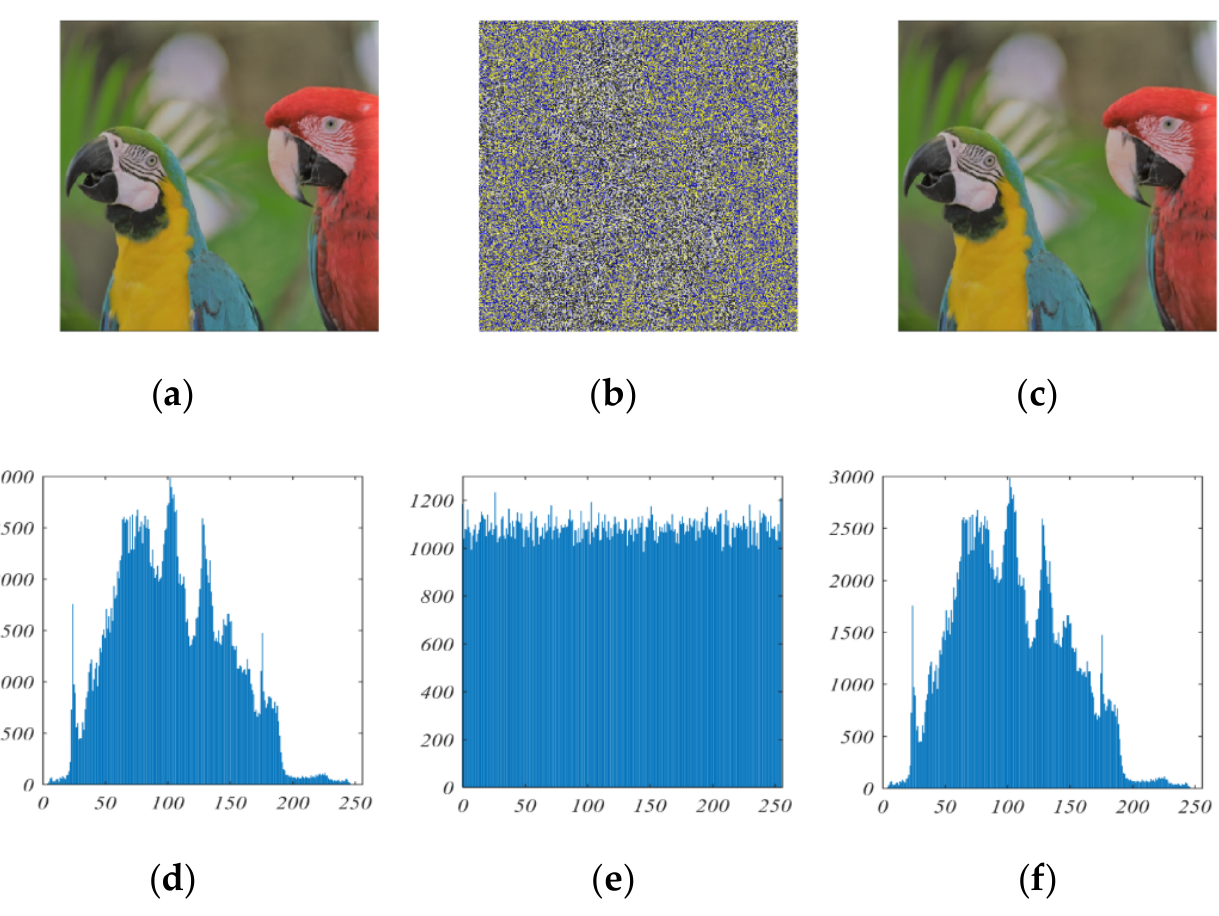
Figure 22. Test of “macaws.jpg”, 300 × 309: ( a ) original image, ( b ) encrypted image, ( c ) recovered image, ( d – f ) histograms consistent with ( a – c ), respectively.